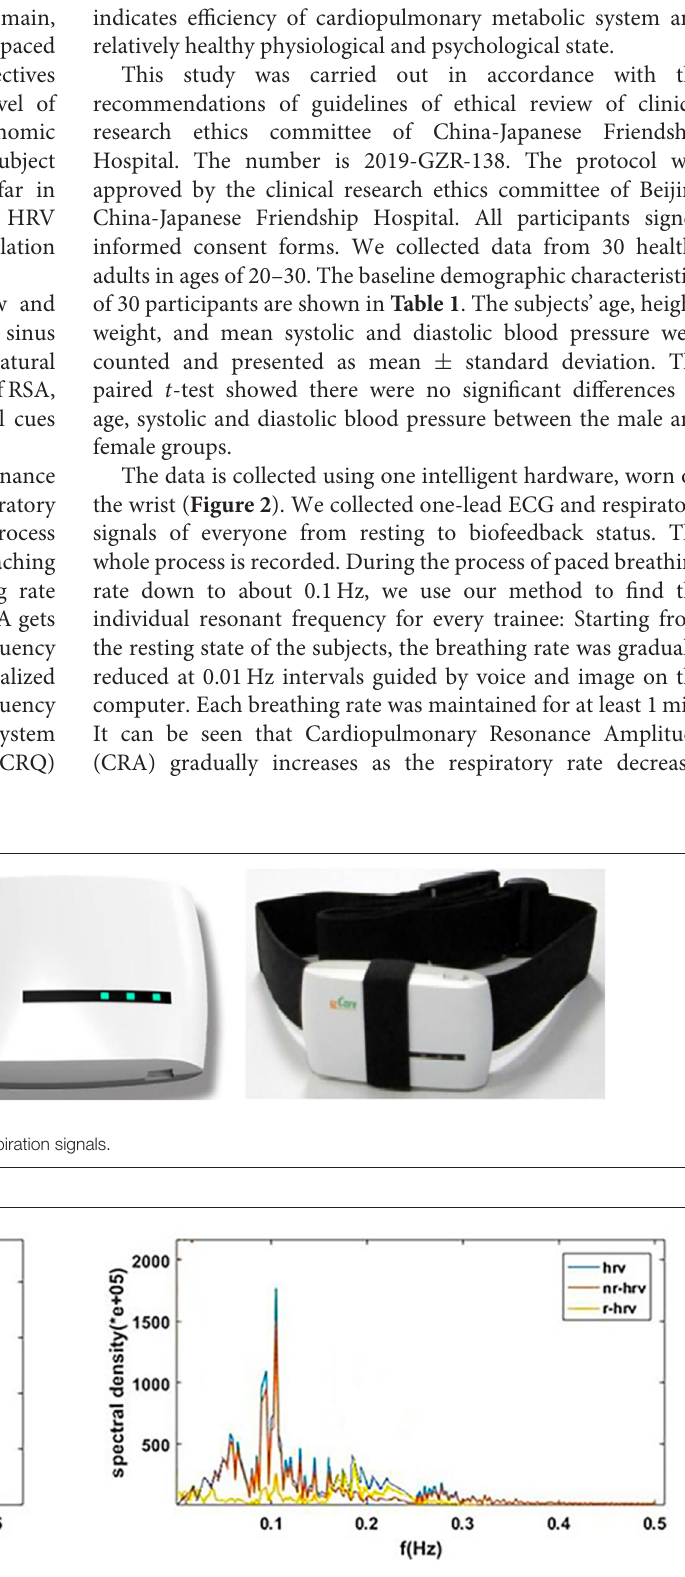
FIGURE 3 | G(f) (CRF) and corresponding HRV, R-HRV, and NR-HRV in frequency domain.